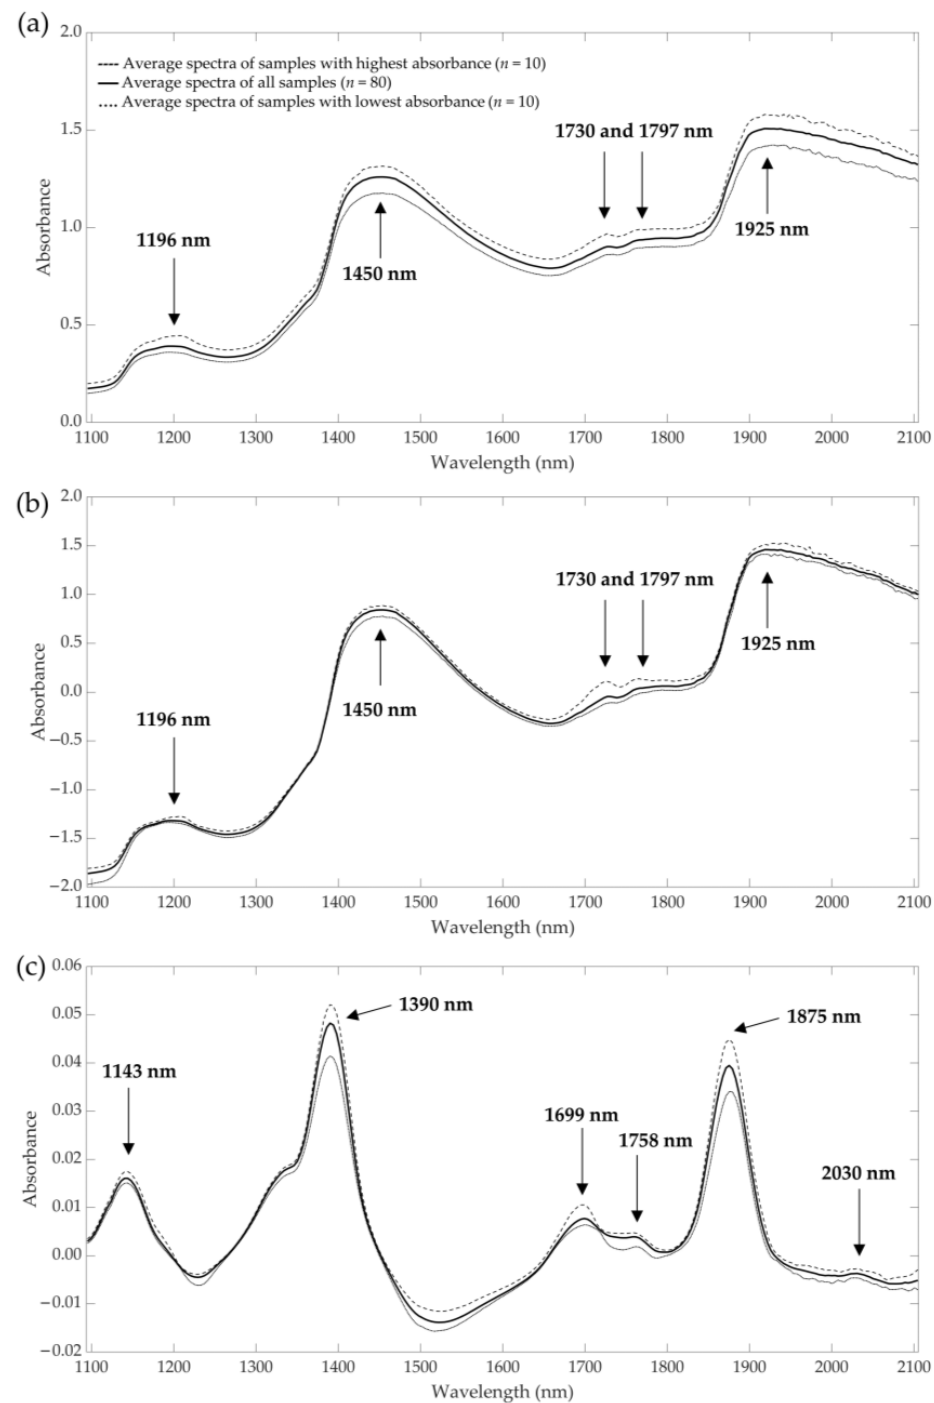
Figure 2. Average NIR raw spectra ( a ) and preprocessed spectra with standard normal variate ( b ) and first derivative ( c ) of living Tenebrio molitor larvae from samples with the highest and lowest absorbance compared to all samples (mean, n = 80).